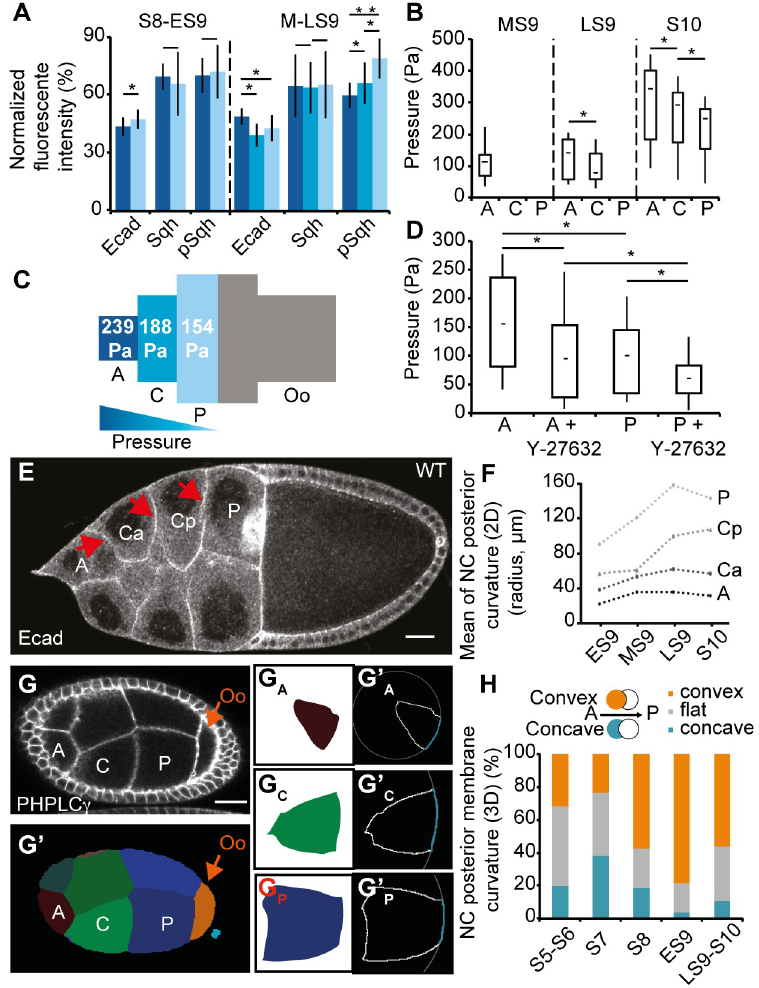
Fig 2. AFM measurements and NC geometry reveal an A/P gradient of cytoplasmic pressure. (A) Percentage of Ecad::GFP (live follicles), Sqh::RFP (live follicles), and pSqh (fixed follicles) expression at the interface between anterior and central (dark blue) NC, or between central abutting the anterior NC and central abutting the posterior NC (cyan, only at MS9 and LS9), or between central and posterior (light blue) NC, relative to the expression between posterior NC and the Oo ( n > 15 per stage). (B) Box and whisker plot of cytoplasmic pressure deduced from AFM in anterior (“A”), central (“C”), and posterior (“P”) NC, from MS9 to S10 WT follicles ( n = 10 for MS9 and LS9 and n = 6 for S10). (C) Schematic representation of mean pressure deduced from AFM in each region of WT S10 follicles, with a color- coded gradient from blue (high) to green (low) ( n > 12 per position). (D) Box and whisker plot of cytoplasmic pressure deduced from AFM in anterior (“A”) and posterior (“P”) NC, at MS9 WT follicles before or after treatment with ROCK inhibitor (Y-27632) ( n = 13 per bar). (E) An LS9 follicle showing the curvature of the membranes (arrows) between the anterior (“A”) and a central NC (“Ca”), between two central NC (“Ca” and “Cp”), or between a central (“Cp”) and a posterior (“P”) NC. “Ca” and “Cp” refer to a central NC in contact with an anterior NC or a posterior NC, respectively. (F) Mean of the NC posterior membrane curvatures (as labeled in E) at either ES9 ( n = 98 cells), MS9 (42 cells), LS9 (25 cells), or S10 (15 cells). (G) An S8 follicle and the corresponding section from a 3D segmentation of the same (G’) with NC labeled from anterior to posterior. G A , G C , and G P correspond to slices showing the largest area for each labeled NC. G’ A , G’ C , and G’ P show the outline (solid white line) of each cell, as well as the circle (dotted white line) fitted to the posterior membrane (blue line). (H) Percentage of convex (orange), flat (gray), and concave (blue) NC posterior membrane curvatures at different follicular stages (2–3 follicles per stage were reconstructed, n > 70). Scale bars: 20 μ m. Data for graphs (A), (B), (C), (D), (F), and (H) can be found in the S1 Data file. A/P, antero- posterior; AFM, atomic force microscope; Ecad, Ecadherin; ES9, early S9; GFP, green fluorescent protein; LS9, late S9; MS9, mid S9; NC, nurse cell; Oo, oocyte; pSqh, phosphorylated sqh; RFP, red fluorescent protein; S, stage; sqh, spaghetti squash; WT, wild